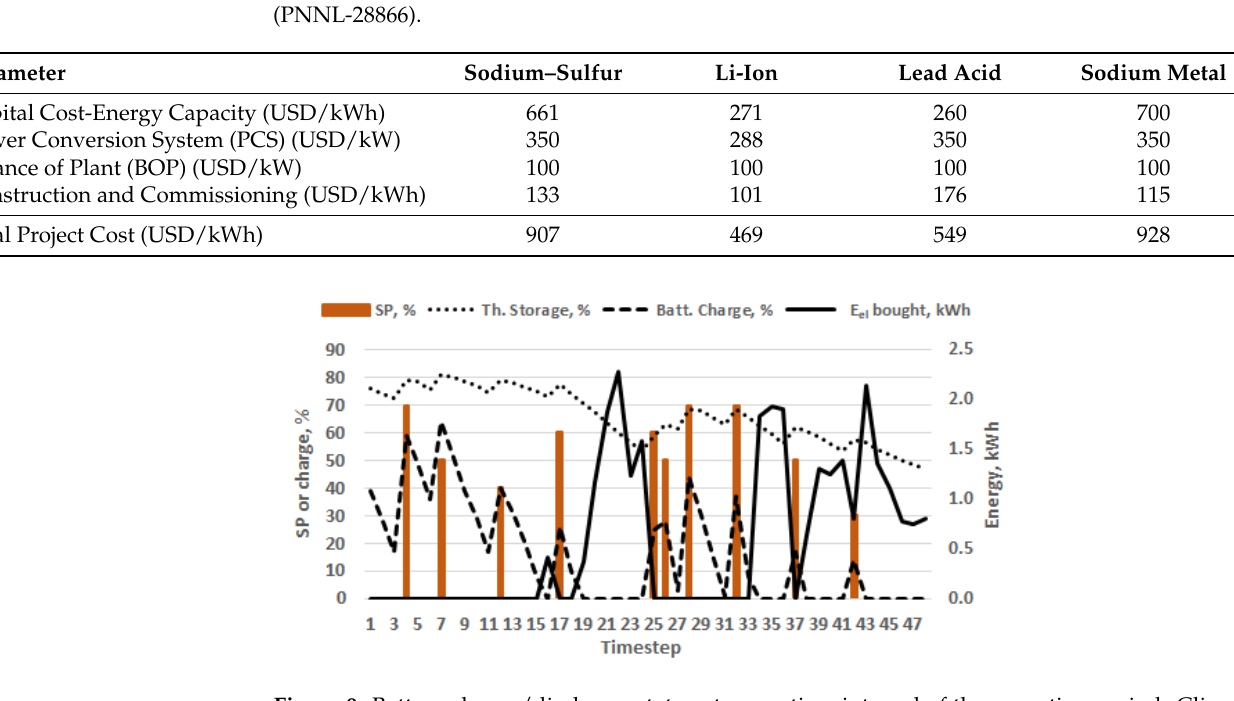
Table 2. Summary of battery types and costs for CHP applications in 2018 according to [24]. Data